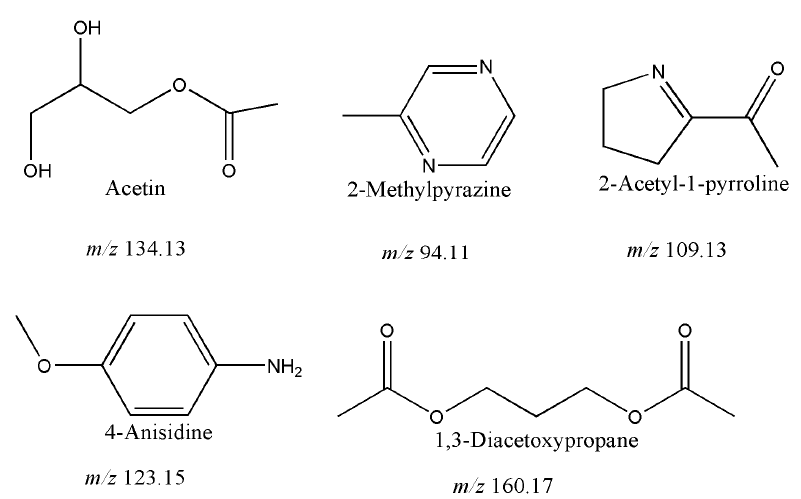
Figure 2. First identification of five volatile metabolites in balsamic vinegar samples showing their chemical structures and molecular weights.